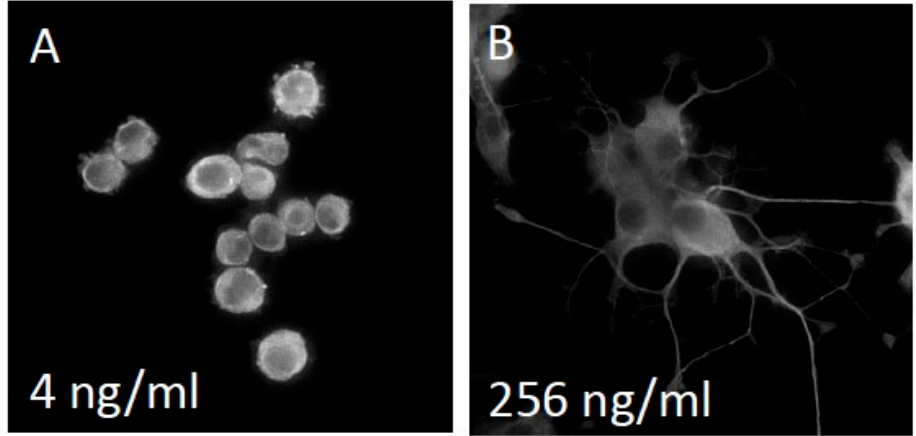
Figure 2. Neuroscreen-1 ™ (NS-1) cells extend neurites in a nerve growth factor (NGF) dependent manner. Representative micrographs of NS-1 cells grown on a collagen-coated surface following 72 h exposure to 0 and 256 ng / ml NGF are shown in panels ( A ) and ( B ), respectively.